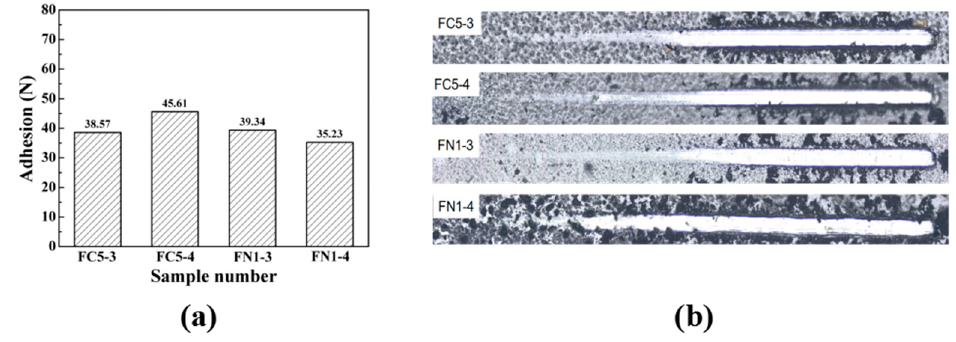
Figure 8. Bonding between carbide substrates and coatings, ( a ) bonding strength, and ( b ) scratching